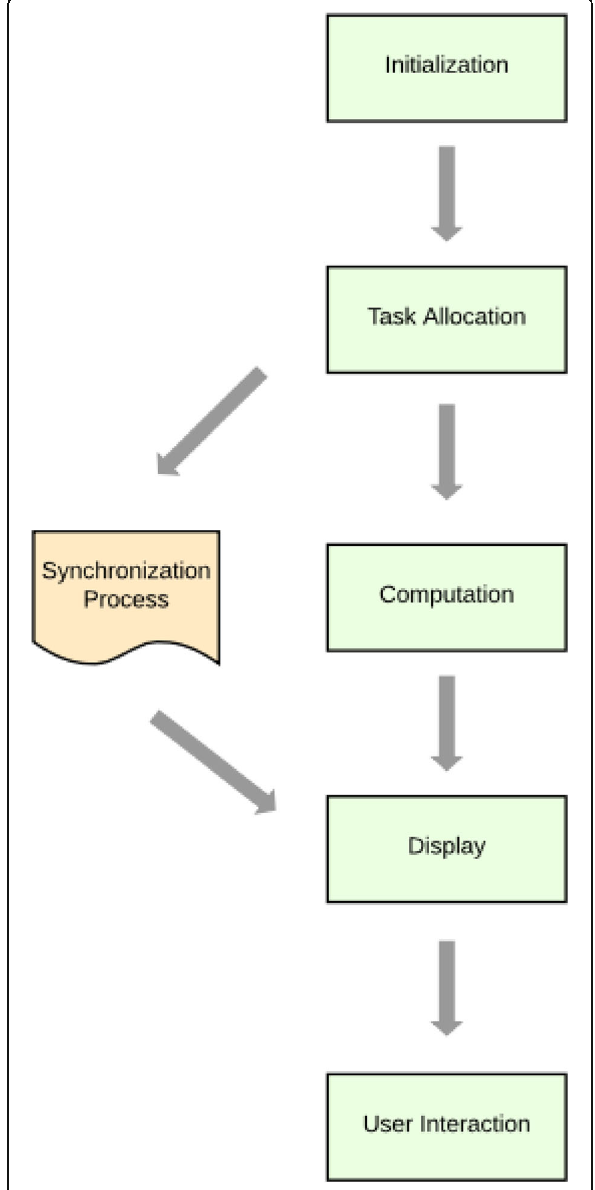
Fig. 1 Data and workflow for mobile AR